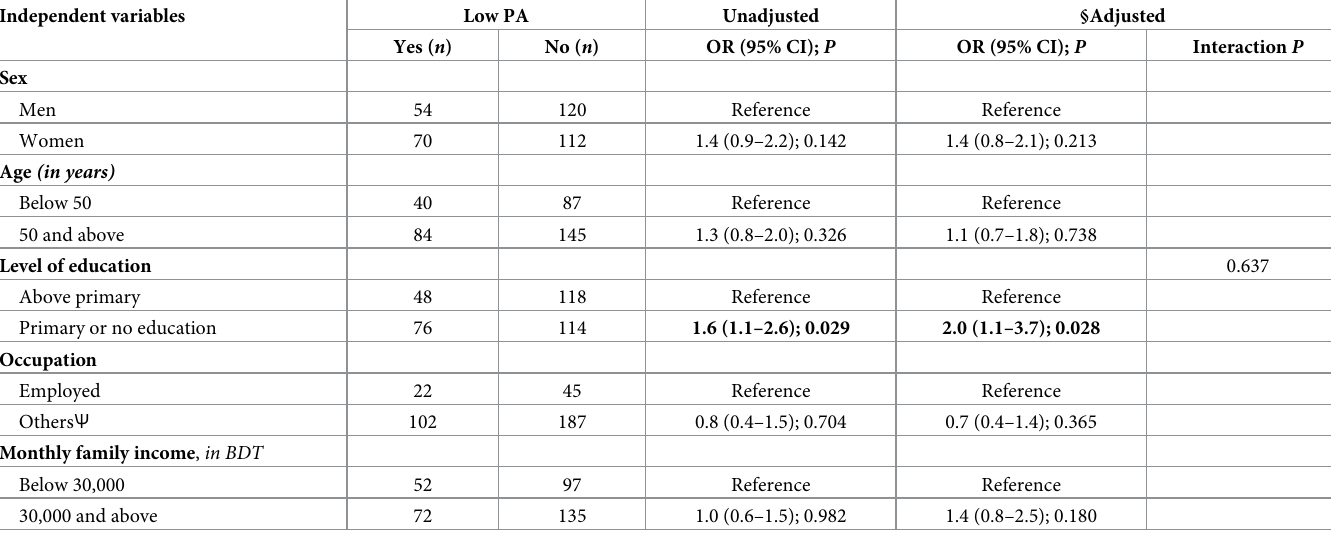
Table 3. Crude and adjusted odds ratios of low physical activity ( < 600 metabolic equivalents) by sociodemographic factors ( n =